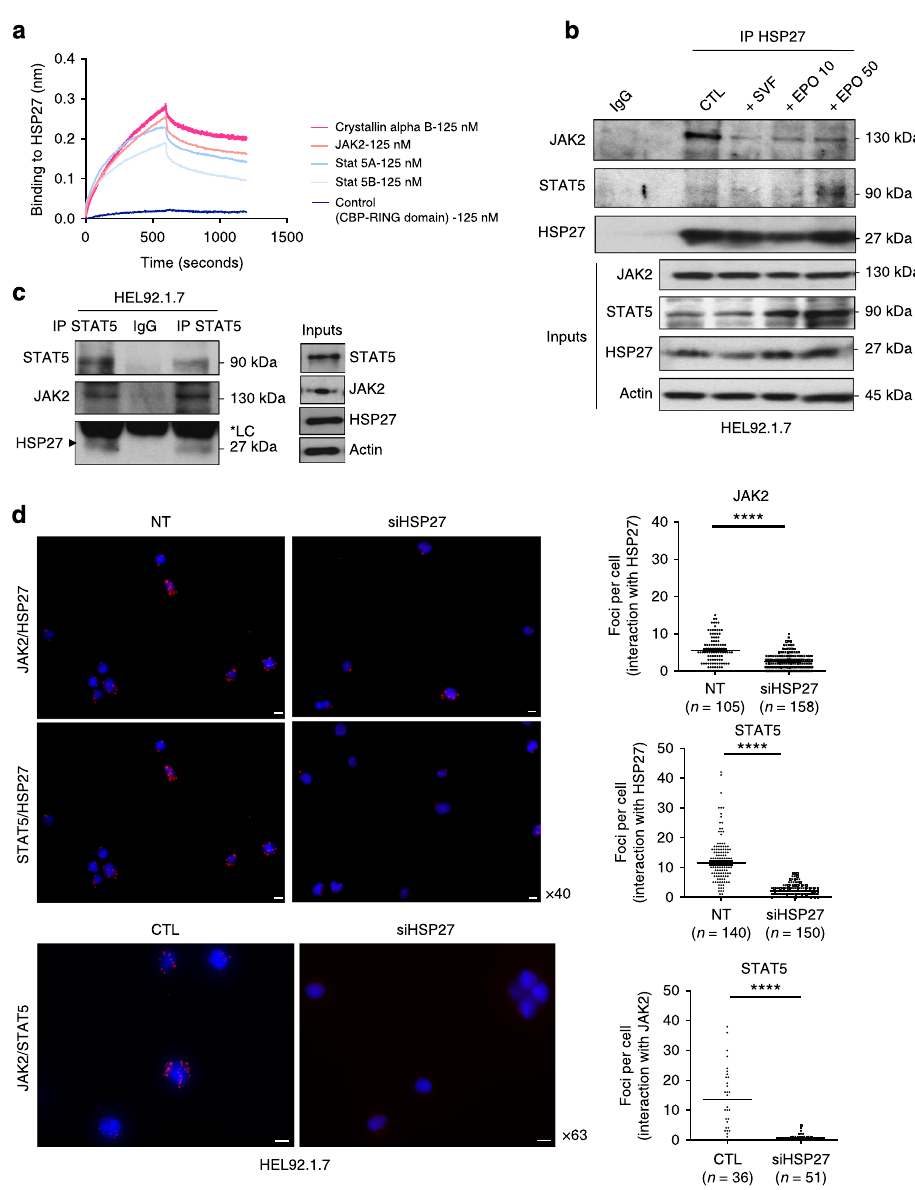
Fig. 5 HSP27 interacts with JAK2/STAT5. a The binding of recombinant JAK2 and STAT5a/b at 125 nM to immobilized biotinylated HSP27 was determined by biolayer interferometry Crystallin alpha B and the CBP RING domain serves as a positive control and negative control, respectively (Supplementary Fig. 4a-c) ( n = 3 independent experiments). b Immunoprecipitation from HEL92.1.7 cell extracts of endogenous HSP27 was followed by immunodetection of endogenous STAT5 and JAK2. CTL: unstimulated cells starved for 16 h; + SVF: Cells starved for 16 h and then stimulated with SVF (10%) for 30 min. Inputs: proteins in total cell lysates. IP IgG: immunoprecipitation with a non-relevant antibody (IgG mouse) ( n = 2 independent experiments). Uncropped blots presented in Supplementary Fig. 8d. c Immunoprecipitation of endogenous STAT5 was followed by immunodetection of